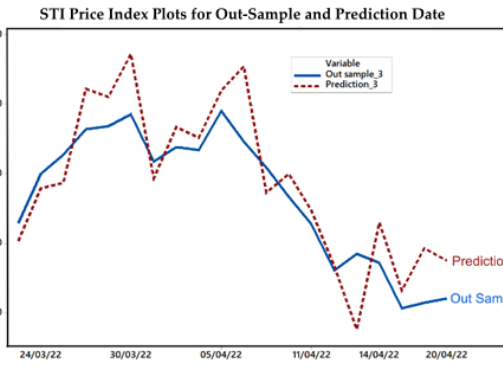
Table 8. MAPE values (%) for GBM-MCS model predictions.